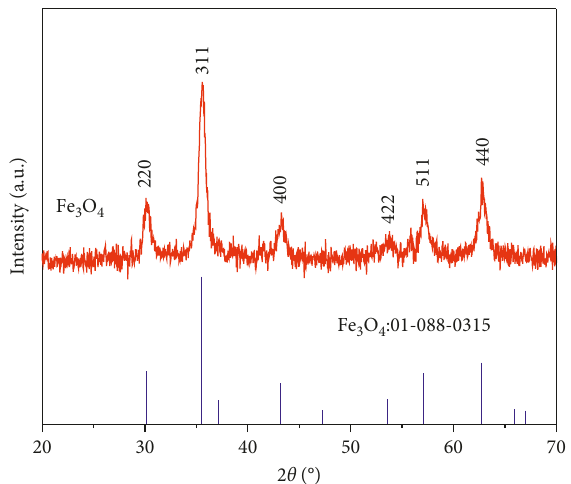
Figure 1: XRD patterns of synthesized Fe